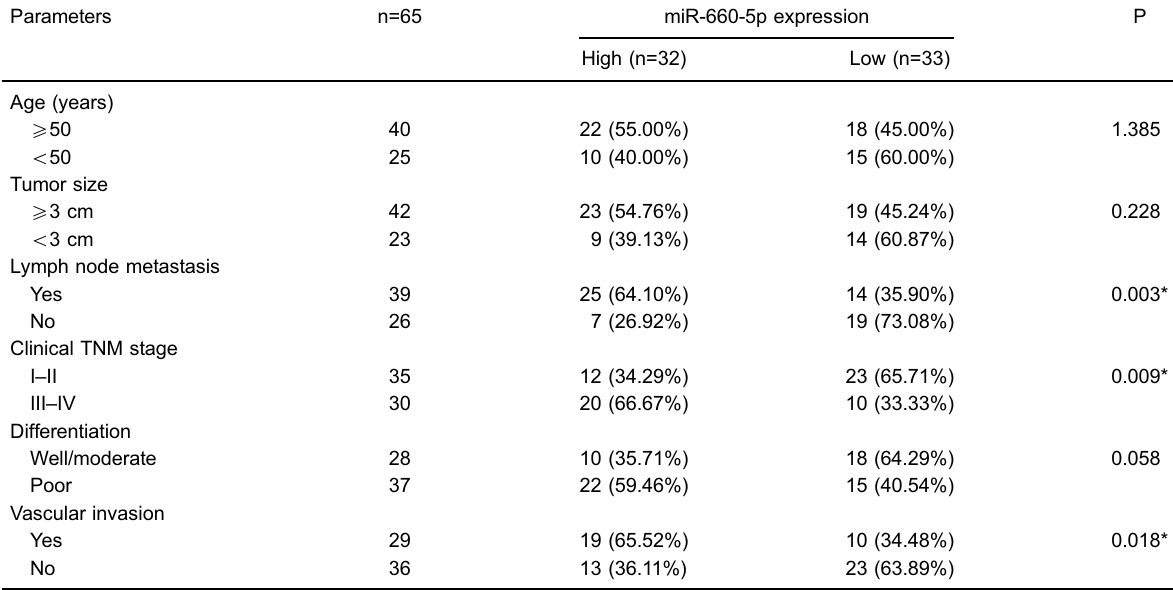
Table 1. Correlation between miR-660-5p expression and clinicopathological features in 65 patients with breast cancer.